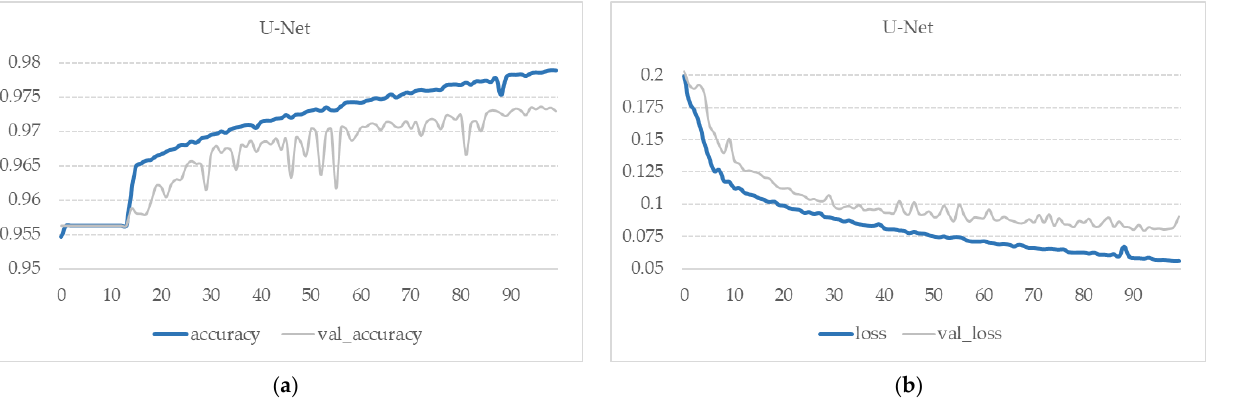
( b ) Figure 6. Model performance: ( a ) accuracy and ( b ) loss for our fine-tuned ENVINet5. All experiments with ENVI deep learning were performed on an Intel ® Core ™ i7- 4771 CPU 3.5 GHz machine with an NVIDIA GeForce GTX 650 GPU with 2 GB of RAM. The training time for 50 epochs was 6 h. 3.2. Detection of Visible Land Boundaries by U-Net After training the CNN model, we evaluated its performance by applying it to the test area (Figure 1a). We applied the trained U-Net model to the test UAV tiles of size 256 × 256 to predict the visible land boundaries. Some results of the predicted boundary maps based on UAV tiles are shown in Figure 7.